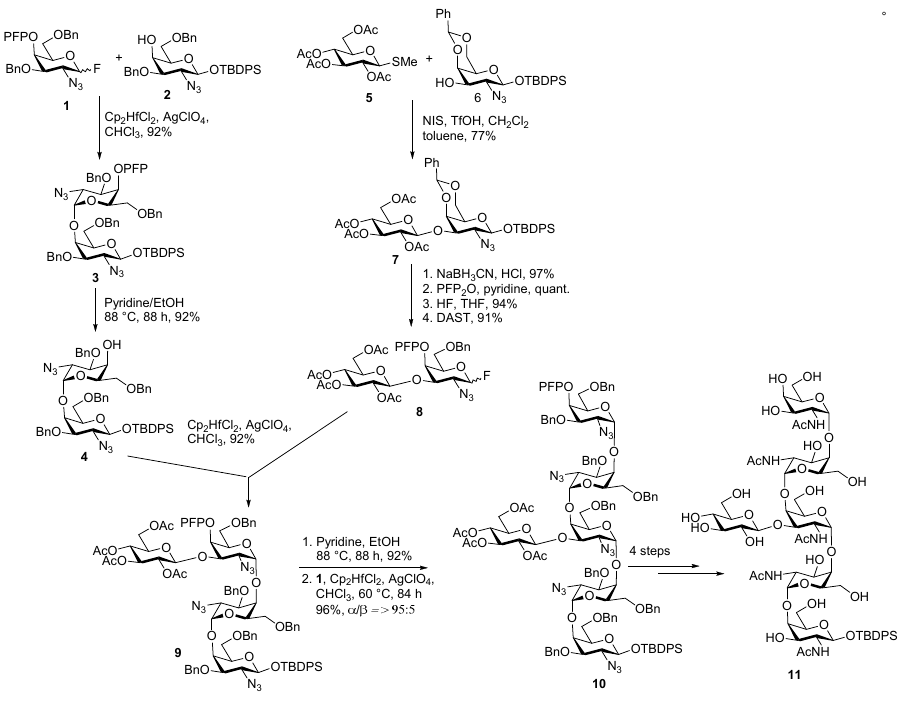
Scheme 1. Ito’s first-generation synthesis of the heptasaccharide from C. jejuni.